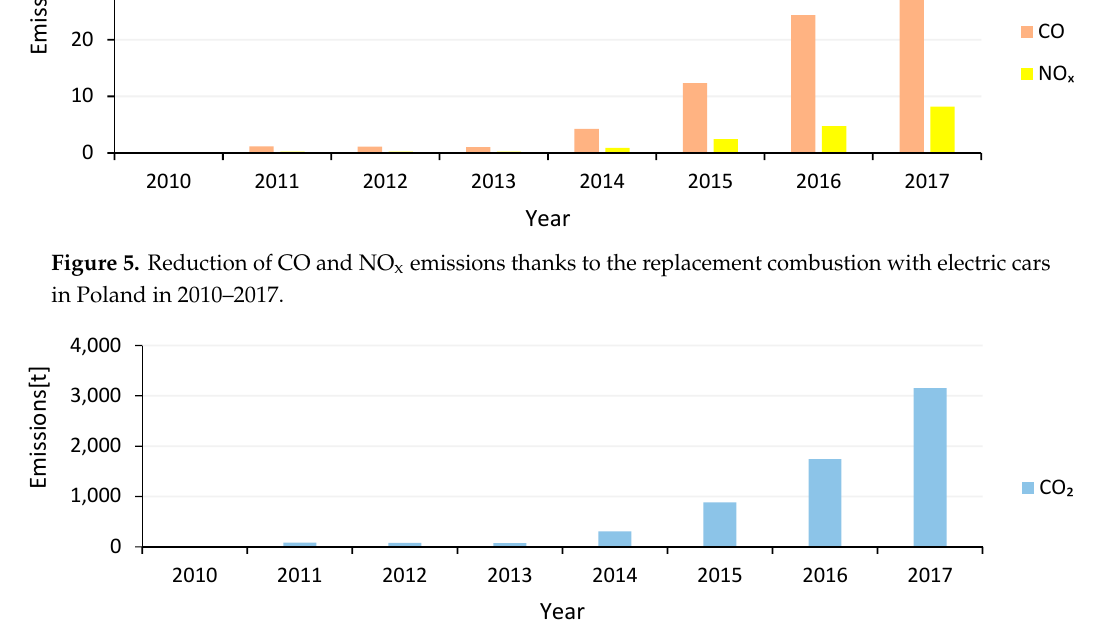
Figure 6. Reduction of CO 2 emissions due to the replacement of combustion with electric cars in Poland in 2010–2017.